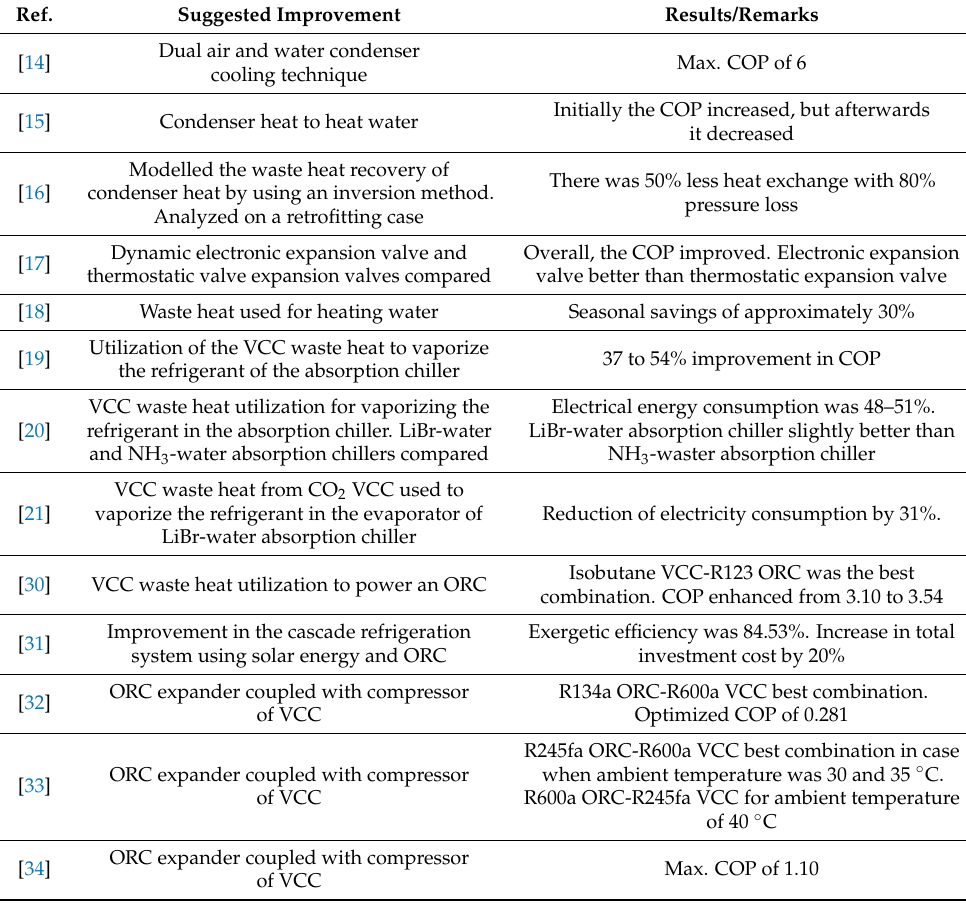
Table 1. Summary of studies performed on enhancing the efficiency of vapor compression chillers.